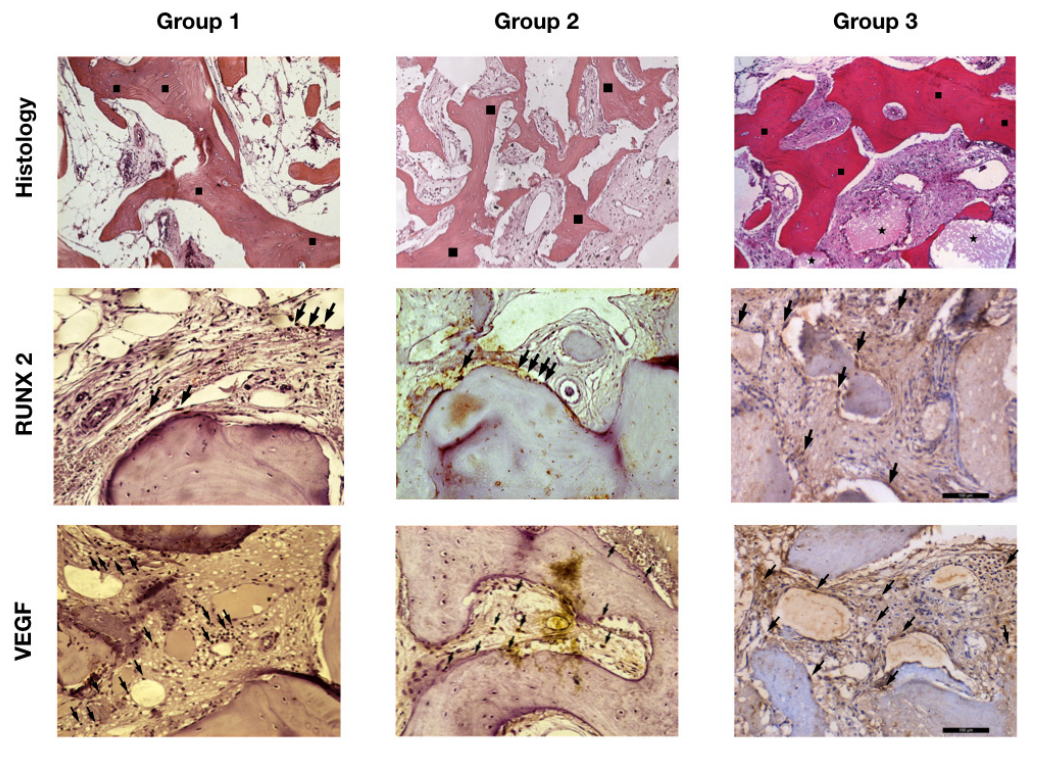
Figure 2. Image showing the histological section for histology evaluation and immunolabeling for RUNX2 and VEGF for the groups evaluated. ( )Lamellar bone formation. ( ) Bion particles remaining. ( ) Immunolabeling cells for RUNX2 and VEGF. [Magnification, × 12.5 ].